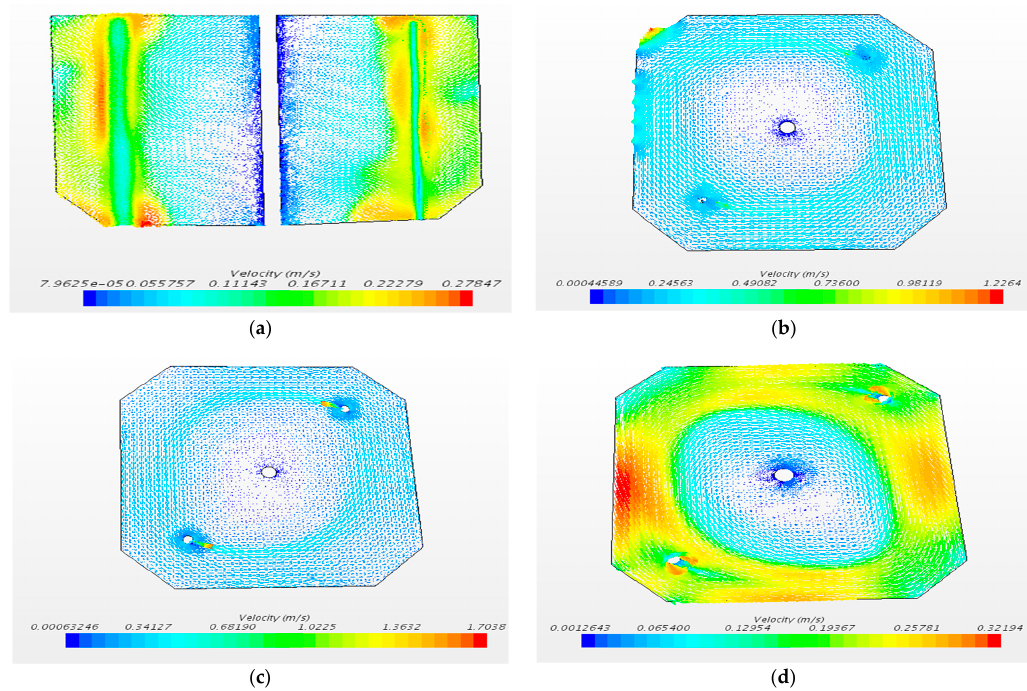
Figure 17. ( a ) middle longitudinal section, ( b ) H = 16.5 m cross section, ( c ) H = 8.5 m cross section, ( d ) H = 1.5 m cross section. (2) Bottom outflow ratio of 30% As shown in Figure 18, the particle emission process in the cabin was simulated and the velocity field at four cross-section positions in the cabin was intercepted under the condition of 30% drainage at the bottom of the aquaculture cabin.